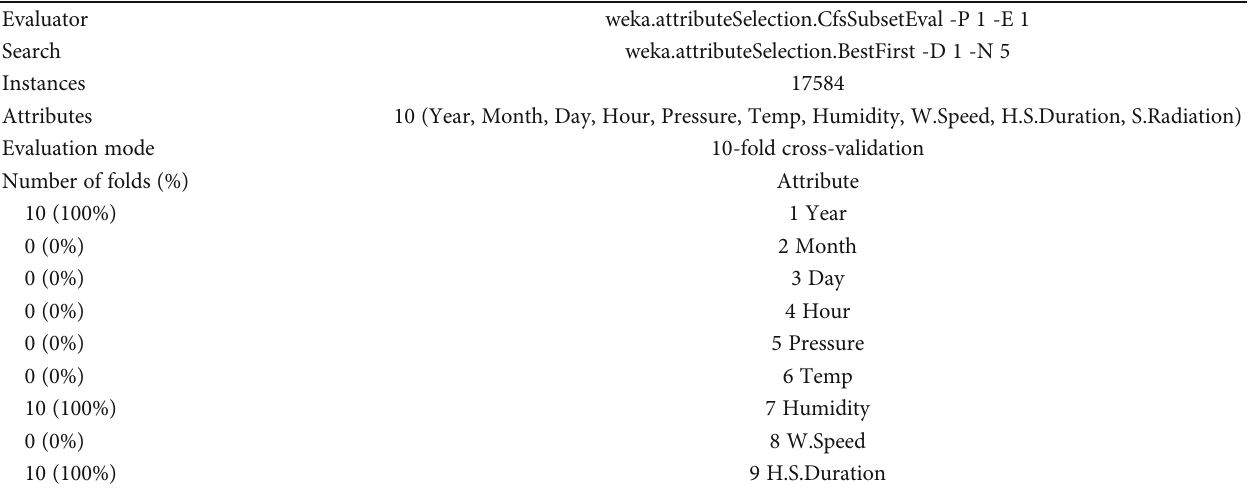
Table 4: Output of a sample feature selection process applied to the dataset of